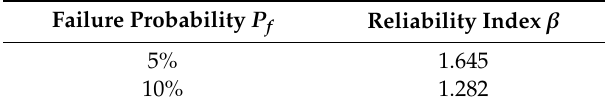
Table 10. Relationship between the failure probability P f and the reliability index β .